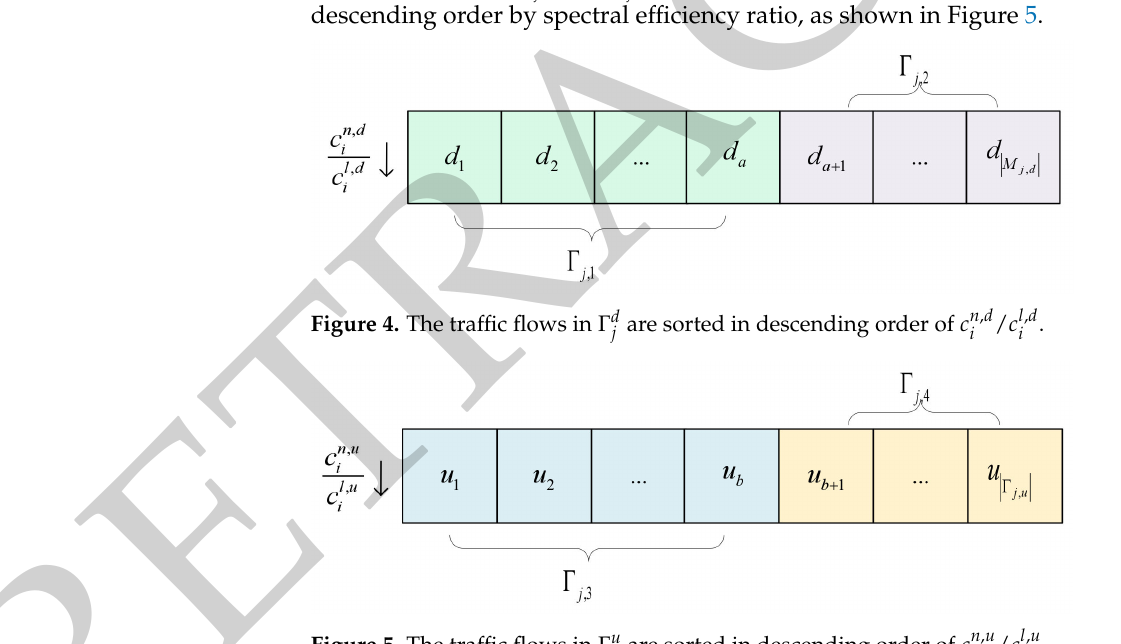
are sorted in descending order of c n , u j